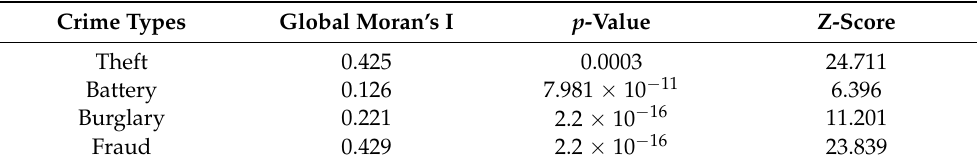
Table 3. Global Moran’s I of local changes between 2020 and 2019 in different crimes. The p -value is the significance level of Moran’s I, and the Z-value is the Moran’s I statistic standard deviation.